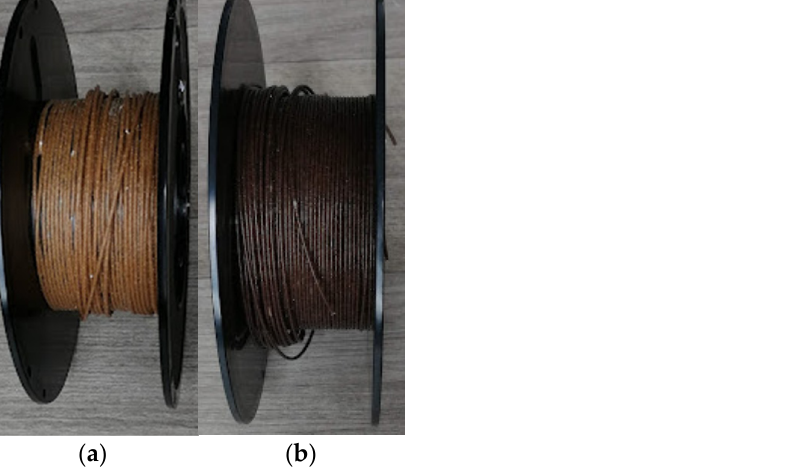
Figure 14. 3D printing filaments based on Colombian agro-industrial waste, ( a ) recycled PP/rice husk 10 wt.%, ( b ) recycled PP/cocoa bean shell 5 wt.%.